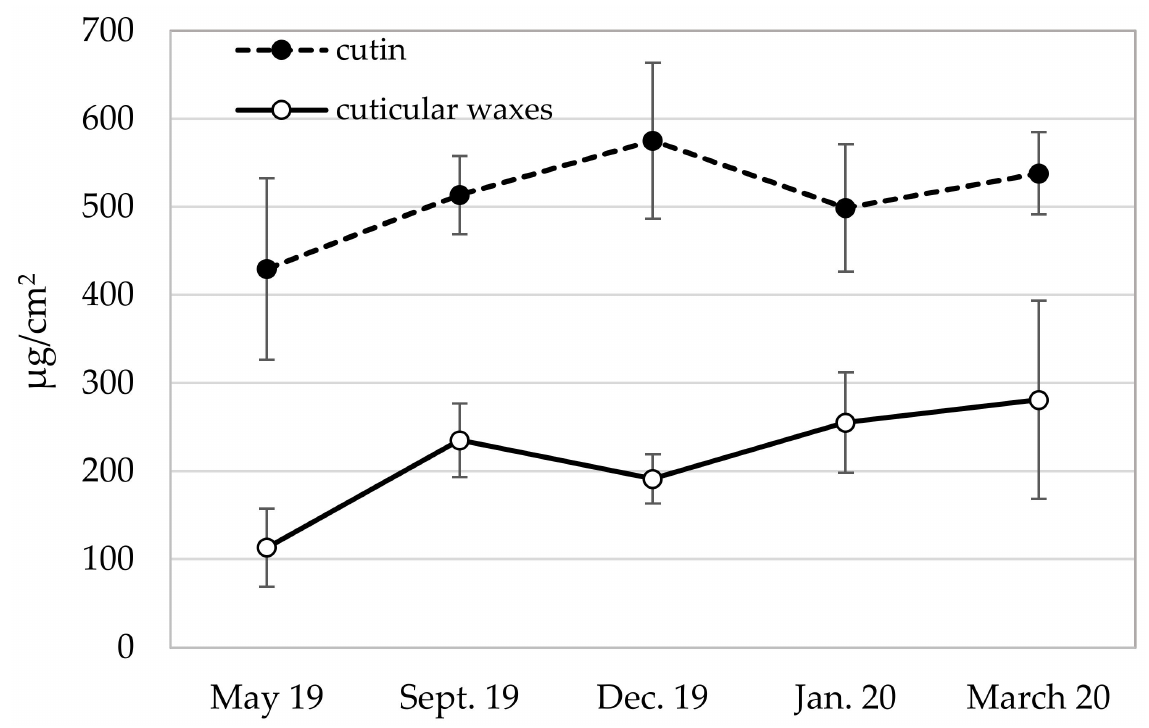
Figure 2. Variation in cuticular waxes and cutin contents in Quercus suber L. leaves along one year (mean of six provenances with two trees per provenance and standard deviation as